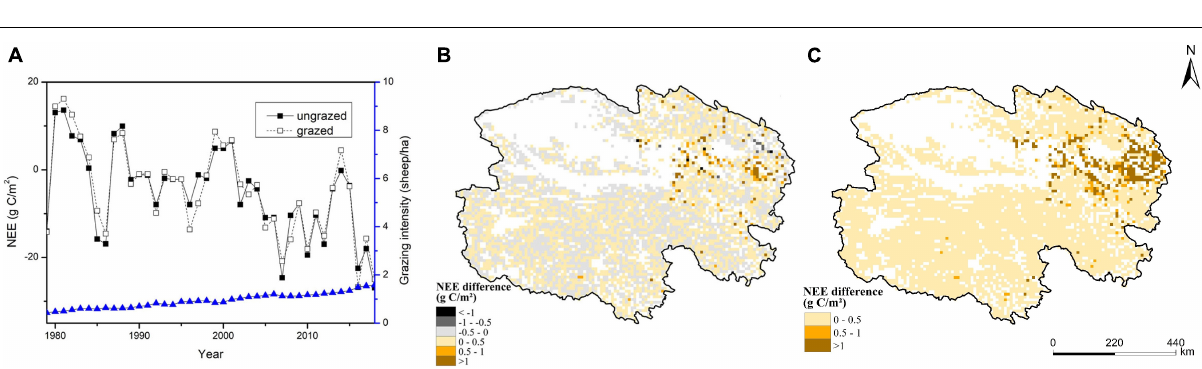
promotes carbon accumulation (Lin et al., 2017; Song et